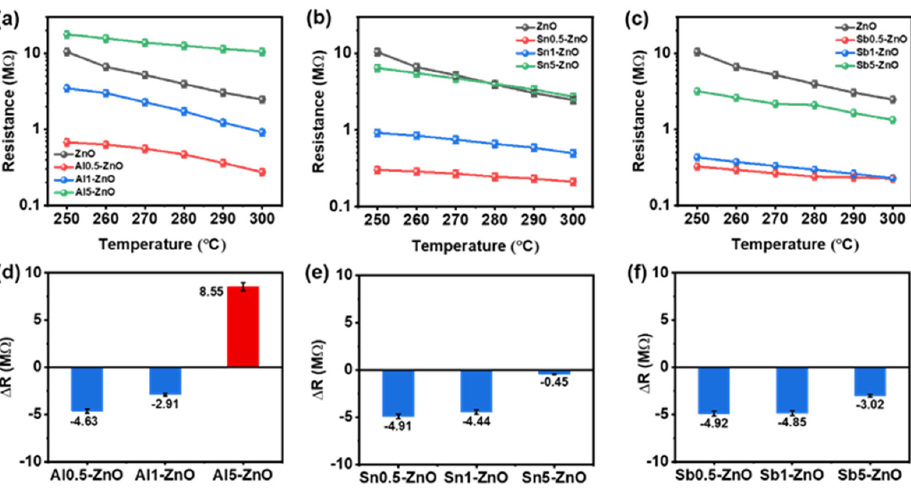
Figure 4. ( a – c ) The baseline resistance of ZnO and various dopants doped ZnO at different tempera-